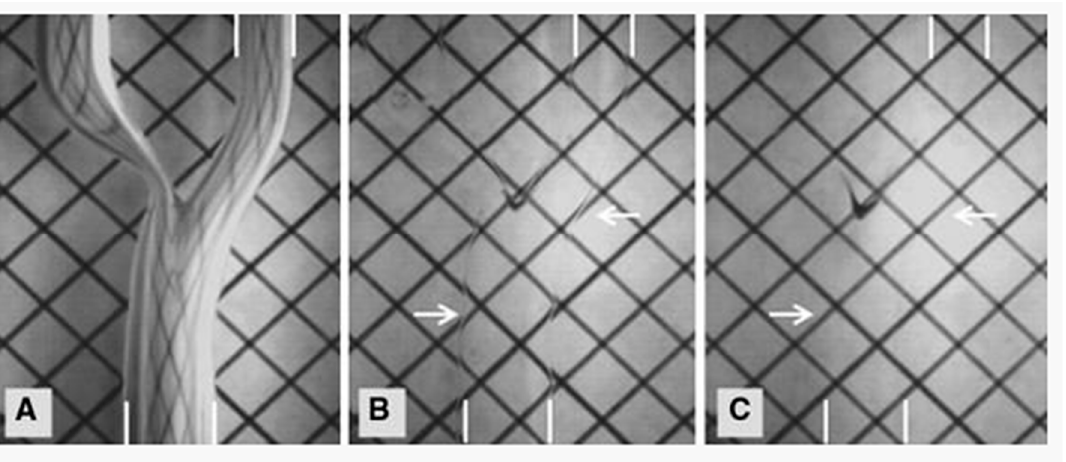
Figure 4. ( a ) Particle image velocimetry (PIV) requires a camera, laser, seeding particles, and optically clear “phantom.” The laser refracts off of the seeding particles and sequential images elucidate specific fluid dynamics; ( b ) Real-time snapshot of a PIV model. Seeding particles are illuminated by the laser and a high resolution camera takes sequential images. Data is analyzed by PIV software. (Courtesy of University of Brighton Youtube Channel [23]).